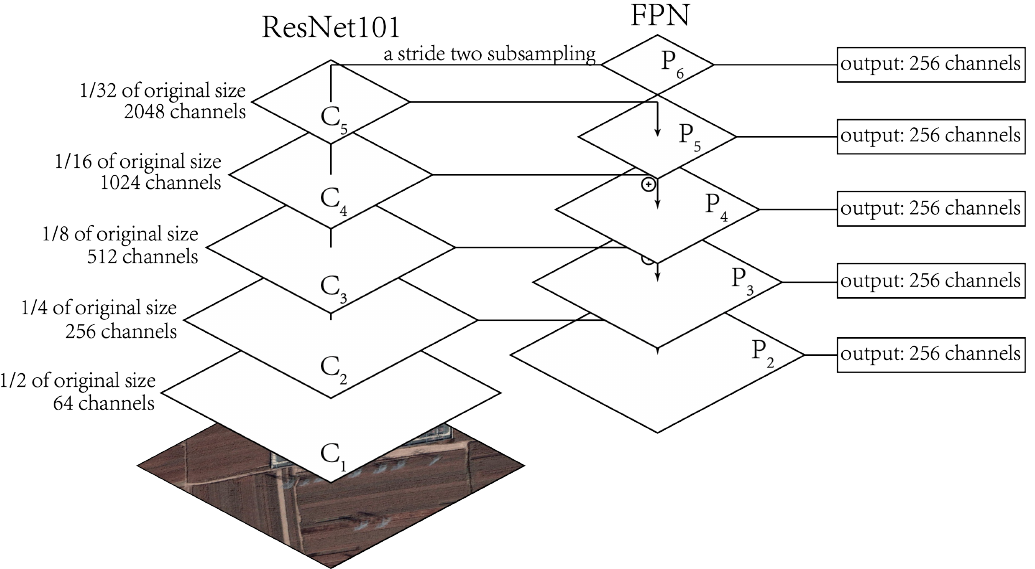
Figure 4. Structure of ResNet101 [42] FPN [43]. The left part shows the structure of ResNet101, which utilizes as the bottom-up pathway. ResNet utilizes a residual learning framework, deepening neural networks by shortcut connections. ResNet outputs five stages of feature maps, C 1 – C 5 , which have features of different scales. The sizes and channels of C 1 – C 5 are shown on their left. The right part shows the top-down structure of FPN. FPN is a component to acquire and merge multi-scale features. (cid:76) means up-sampling coarser-resolution feature maps and merging it with the corresponding bottom-up map. P 2 – P 6 which have 256 channels are the output of FPN, imported to different